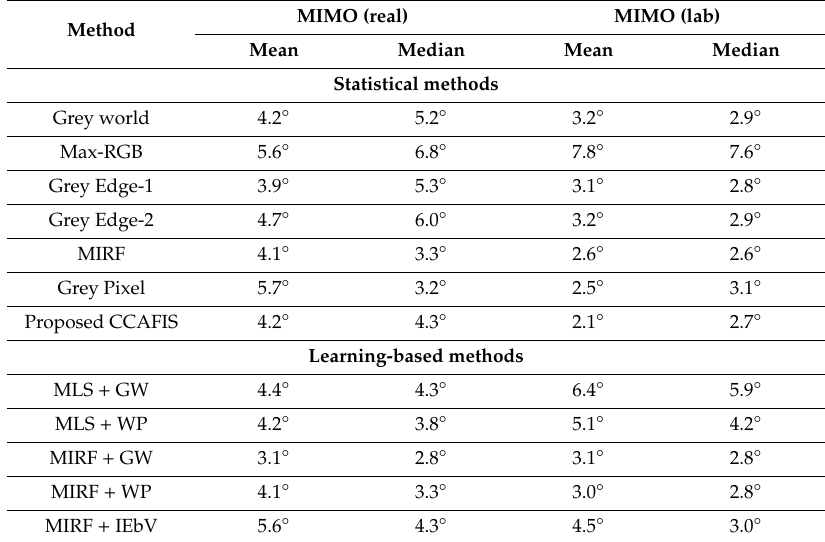
Table 5. Mean and median recovery angular error of various methods on images of the MIMO dataset.